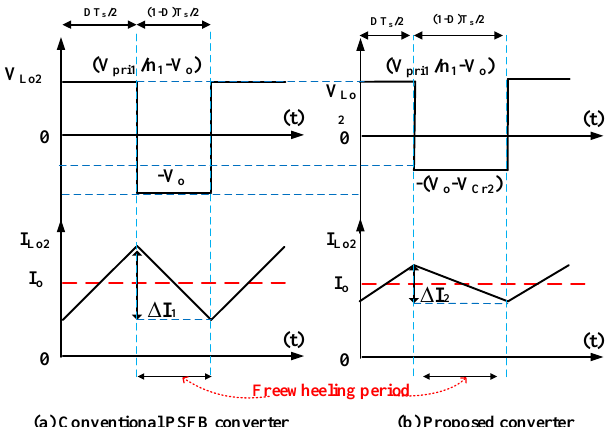
Figure 7. Comparison of the circulating current in the conventional PSFB converter and proposed converter.